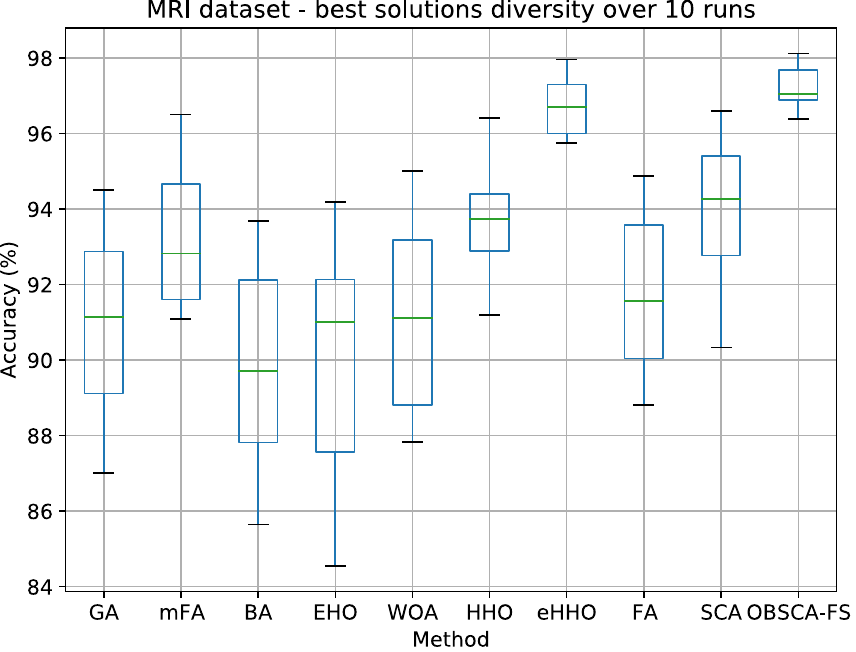
Figure 7. MRI dataset—best solutions diversity over 10 runs results.